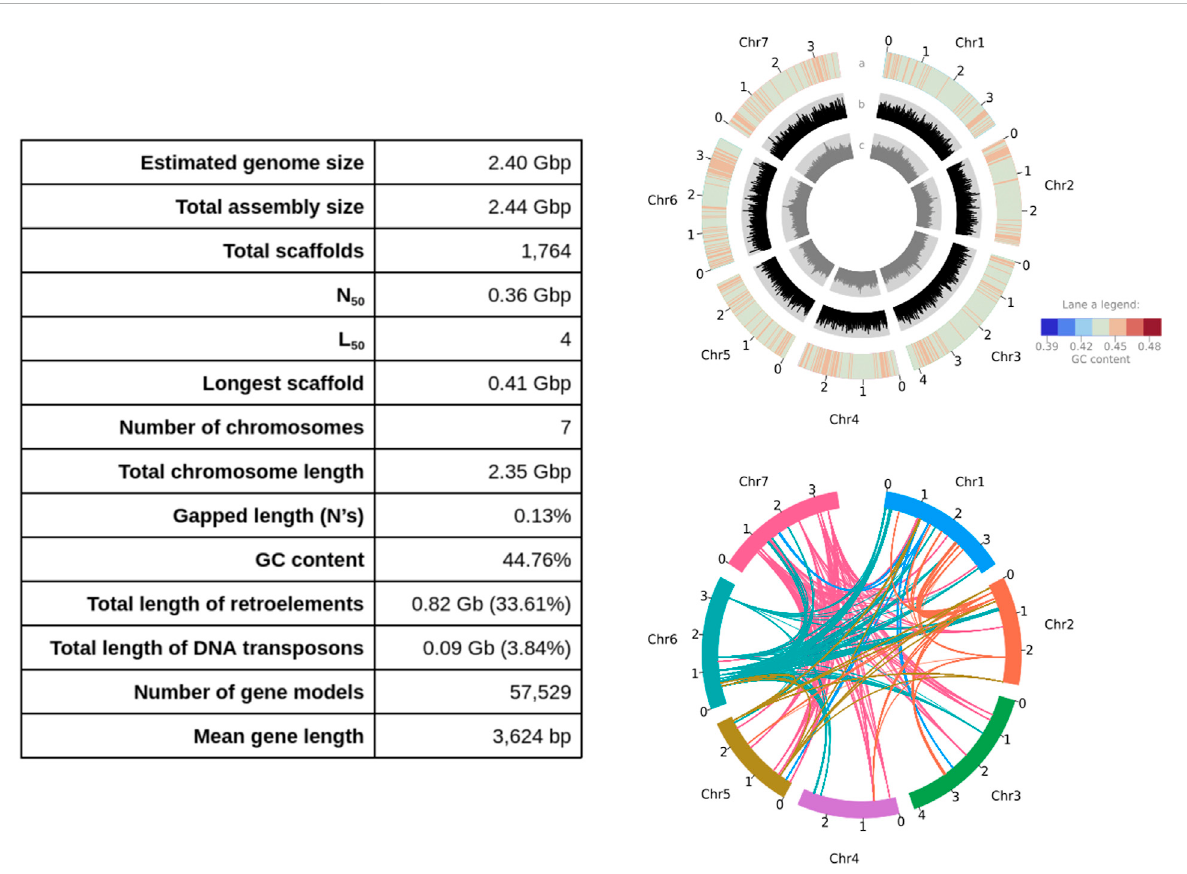
FIGURE 1 Left panel: Assembly statistics, and right panel: features of the Lolium rigidum genome (each tick is ×100 Mb). Top right panel — lane (a) GC content heatmap of mean GC content per 2.35 Mb window (ranging from 42% to 47%); lane (b) distribution of Copia long terminal repeat (LTR) retrotransposon family; lane (c) distribution of Gypsy LTR retrotransposon family. Bottom right panel: chord diagram shows the syntenic relationships within the top 5 orthogroups with the most paralogs in the genome (i.e. F-box domain-containing protein family, F-box protein interaction domain protein-related family, auxin-responsive protein family, and two orthogroups with unknown function: OS06G0725500 and PTHR32141), where the colours match the colours of the chromosome most of the paralogs per orthogroup are